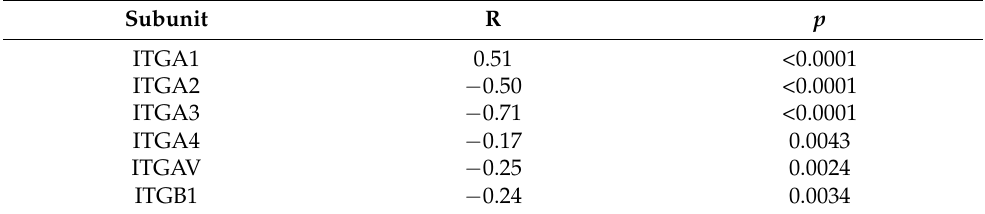
Table 1. Spearman analysis of the correlation between integrin subunits and Differentiation score as described in